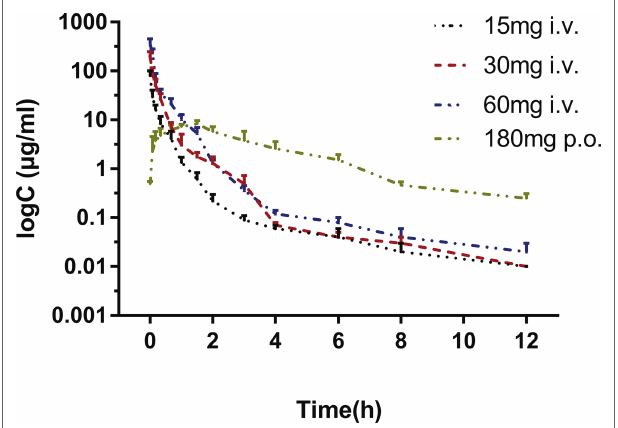
FIGURE 2 | Mean plasma concentration-time curves of sodium danshensu after intravenous administration of 15, 30, 60 mg/kg and oral administration 180 mg/kg in rats ( n =